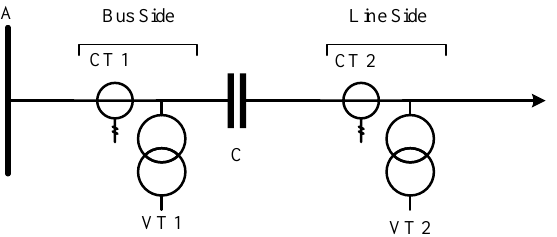
Figure 9. Alternative positions of current and voltage transformers relative to series